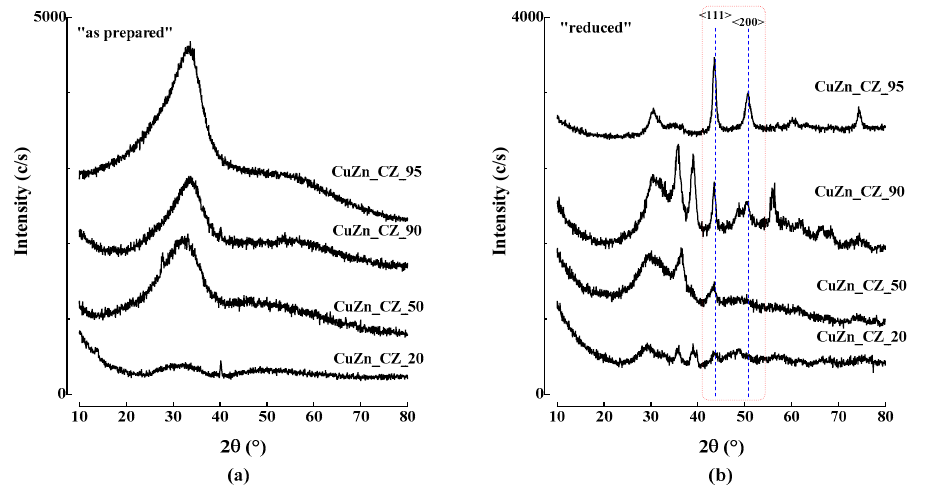
Figure 2. X-ray diffraction (XRD) patterns of Cu-ZnO based catalysts: ( a ) as prepared and ( b ) reduced.